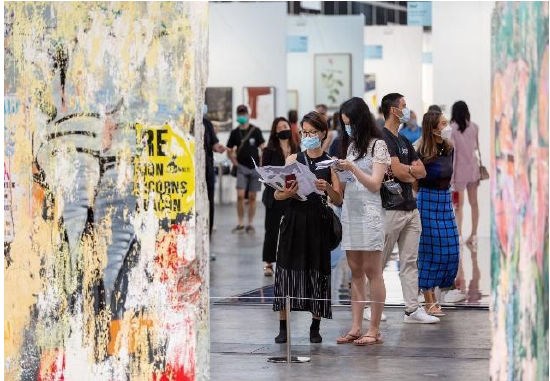
Figure 3. Visitors at the Art Basel Hong Kong 2021, May 2021. Image Courtesy of Art Basel.